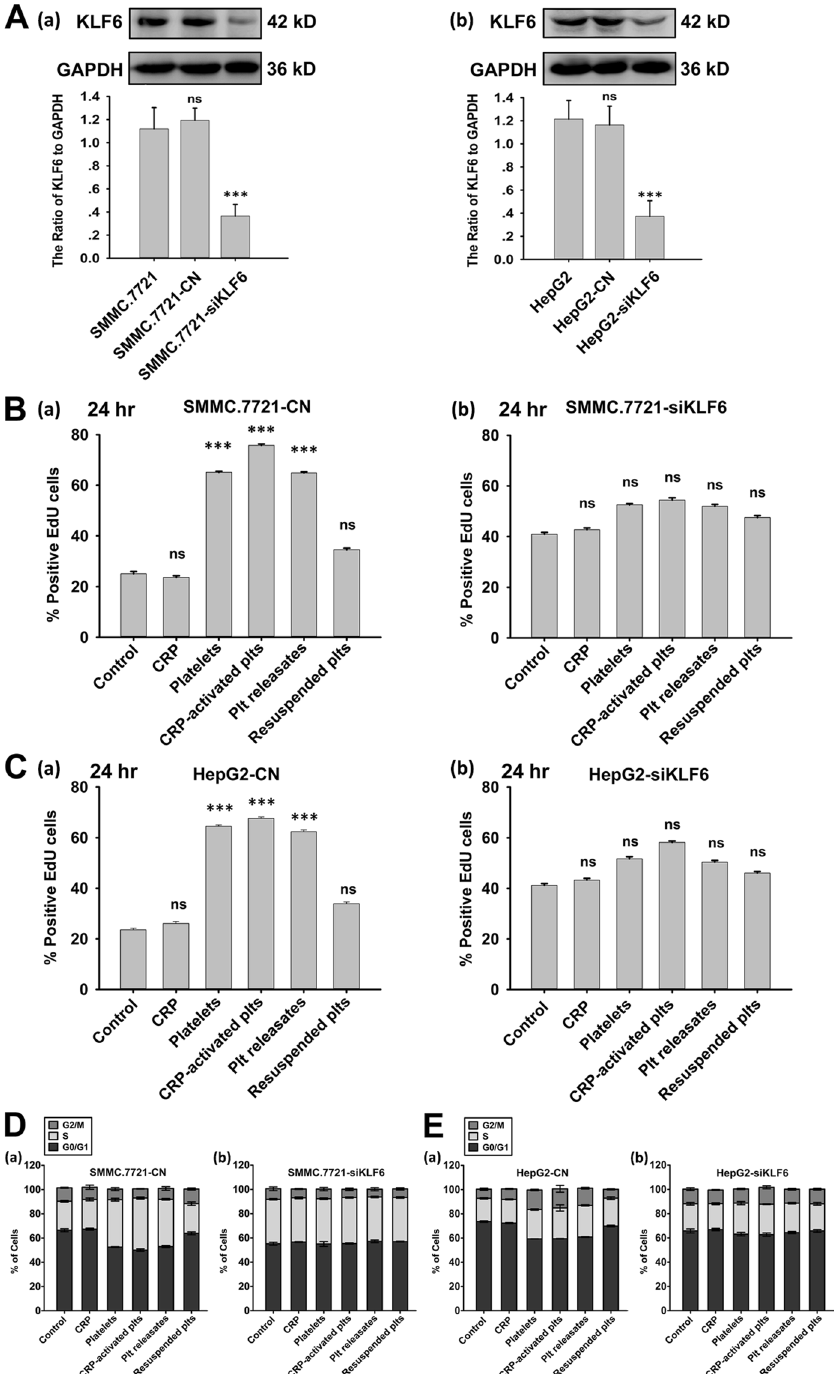
Figure 3. Knocking down KLF6 expression in HCC cells abrogated the proliferative effect of platelets. ( A ) SMMC.7721 (a) and HepG2 (b) cells were transfected with either control shRNA (CN) or KLF6 shRNA (siKLF6) for 96 hours, and KLF6 expression was visualized by a Western blot. GAPDH served as a loading control. A quantitative analysis of the ratio of KLF6 to GAPDH expression is shown, and data are presented as the mean ± SEM (n = 3, *** p < 0.001 compared with control). ( B,C ) SMMC.7721 ( B ) and HepG2 ( C ) cells stably transfected with control shRNA (a, CN) or KLF6 shRNA (b, siKLF6) were incubated with the indicated components. EdU incorporation was measured to determine HCC cell proliferation after incubation for 24 hours, and the respective cell type cultured in fresh medium served as a control. The data are presented as the mean ± SEM ( *** p < 0.001 compared with controls. Five randomly selected fields were examined at x200 magnification, and the experiment was repeated three times). ( D,E ) Cell cycle analysis of SMMC.7721 cells transfected with control shRNA ( D (a)), SMMC.7721 cells transfected with KLF6 shRNA ( D (b)), HepG2 cells transfected with control shRNA ( E (a)), and HepG2 cells transfected with control shRNA ( E